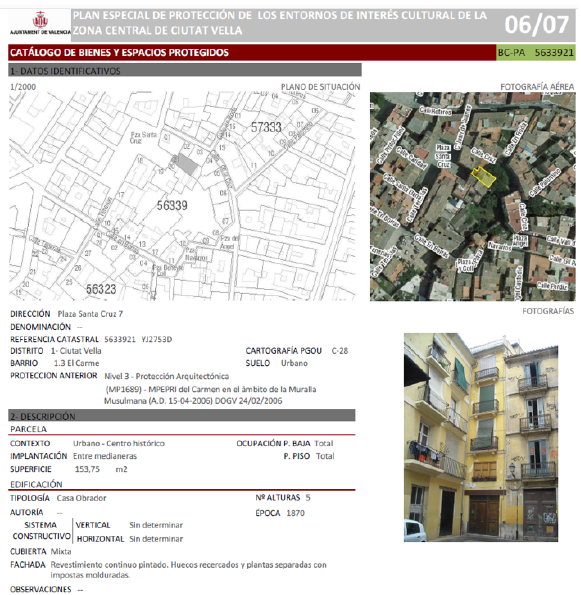
Figure 8. Record file of a building included in the Catalogue of listed buildings of the Special Protection Plan of Ciutat Vella (Source: Ayuntamiento de Valencia).